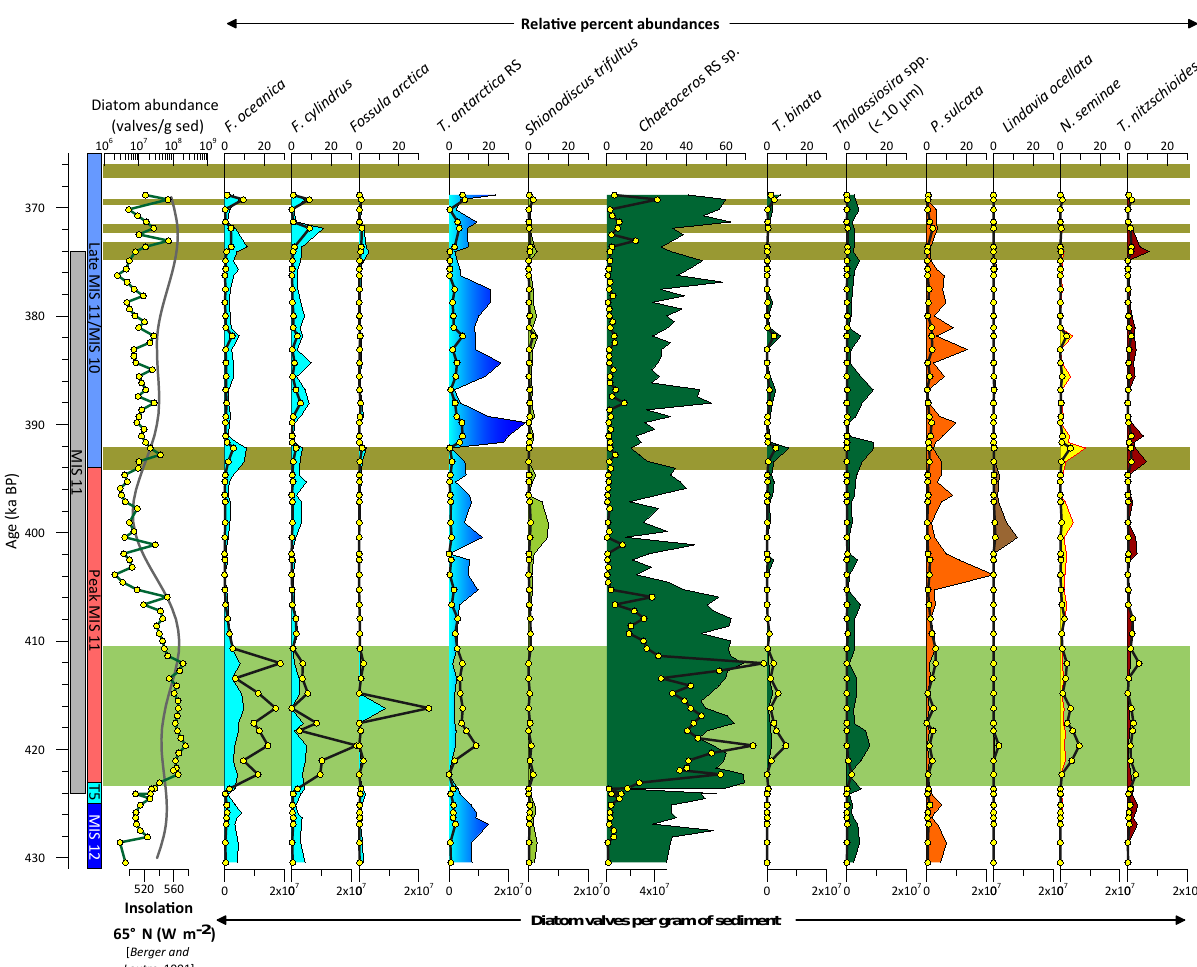
Figure 6. Absolute and relative percent abundances of all diatoms that occur in abundances greater than 10% of any assemblage. Colored vertical bars refer to the zones mentioned in the text. Line plots depict absolute abundance and area plots depict relative percent abundance. Species are color-coded according to the niche that they are grouped into: marginal ice zone (light blue), both ice types (dark blue to light blue), dicothermal (light green), high productivity (green), neritic (orange), freshwater (brown), North Pacific (yellow), and warm water (red). Insolation at 65 ◦ N (light-grey line) is also shown. Type I laminations are depicted as pale-green bars and type II laminations are depicted as olive-green